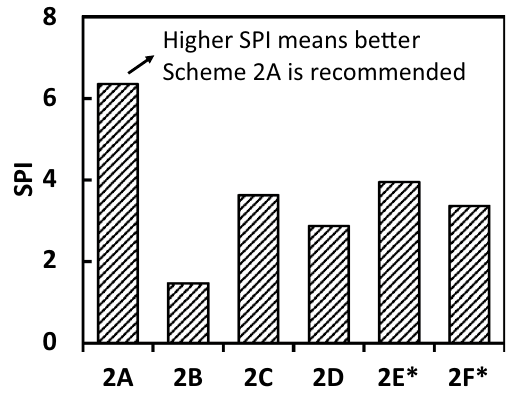
Fig. 7 Comparison of surfactant performance index 𝝍 . The definition of better is the higher SPI. Higher SPI contributes to obtain the great- est IFT reduction their biosurfactant. This eventually results in less biosur- factant concentration and higher IFT.